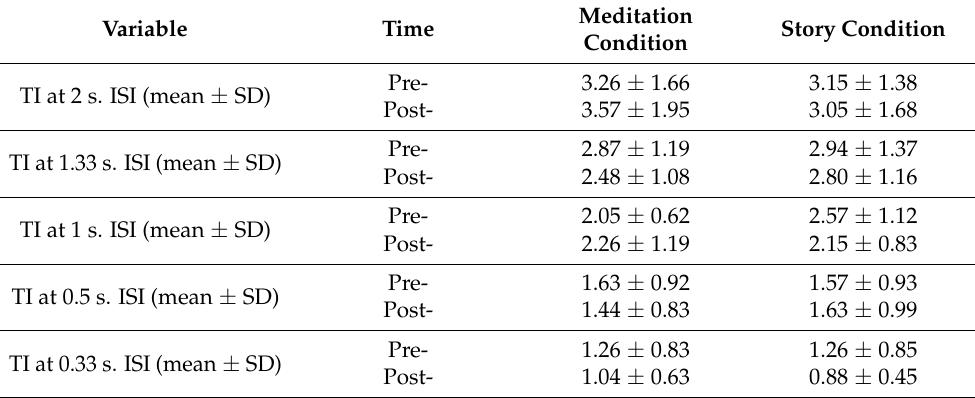
Table 4. Descriptive statistics for temporal integration (TI) at different metronome frequencies (n = 19) for the two conditions (meditation,